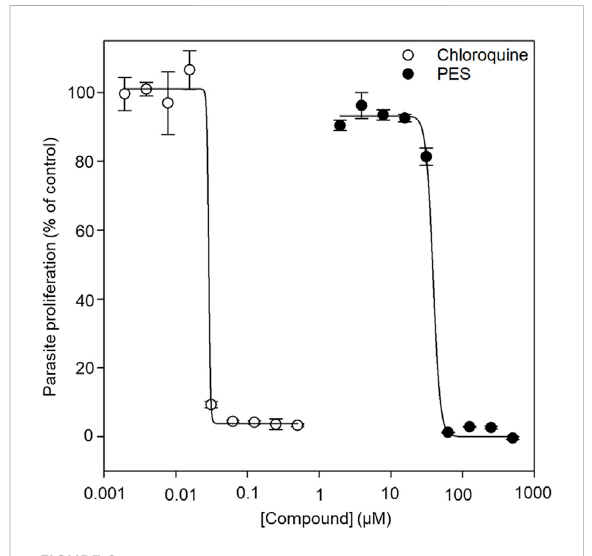
FIGURE 9 The normalized dose-response curve for the in vitro susceptibility of P. falciparum to PES. The in vitro antiplasmodial activity of PES was investigated using a SYBR ™ Gold DNA stain to measure the proliferation of the parasites as compared to the controls. Fluorescence was measured using a TECAN Spark ® multimodemicroplatereaderandthedataanalysiswasdoneusing SigmaPlot, version 12 (Systat Software Inc., Chicago, IL, United States). IC 50 determinations were performed as technical triplicates for three biological repeats with standard error of the mean shown.